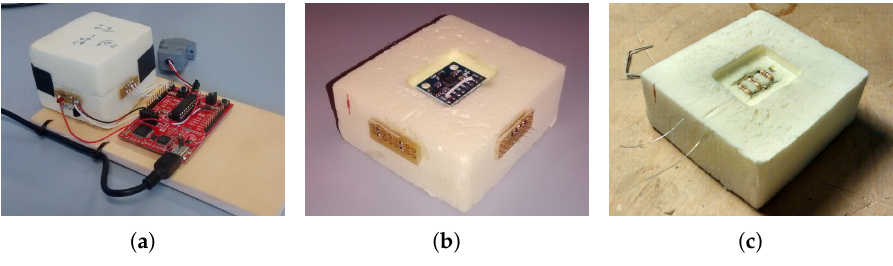
Figure 19. Temperature control for gyroscope: ( a ) control circuit; ( b ) thermal box; ( c ) heating resistors.